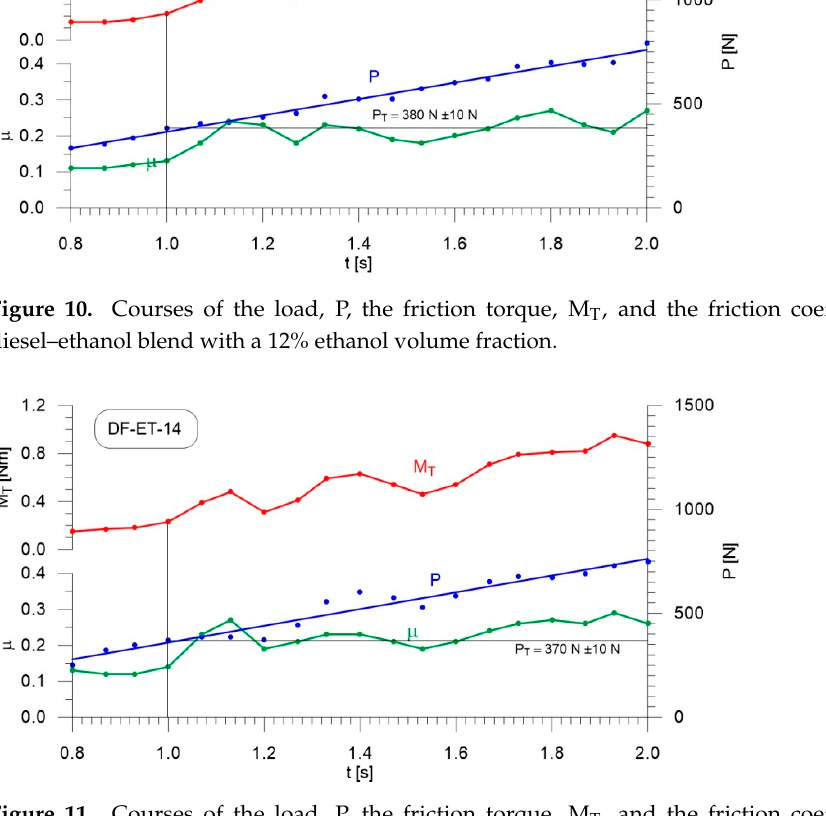
ethanol blend with a 14% ethanol volume fraction.